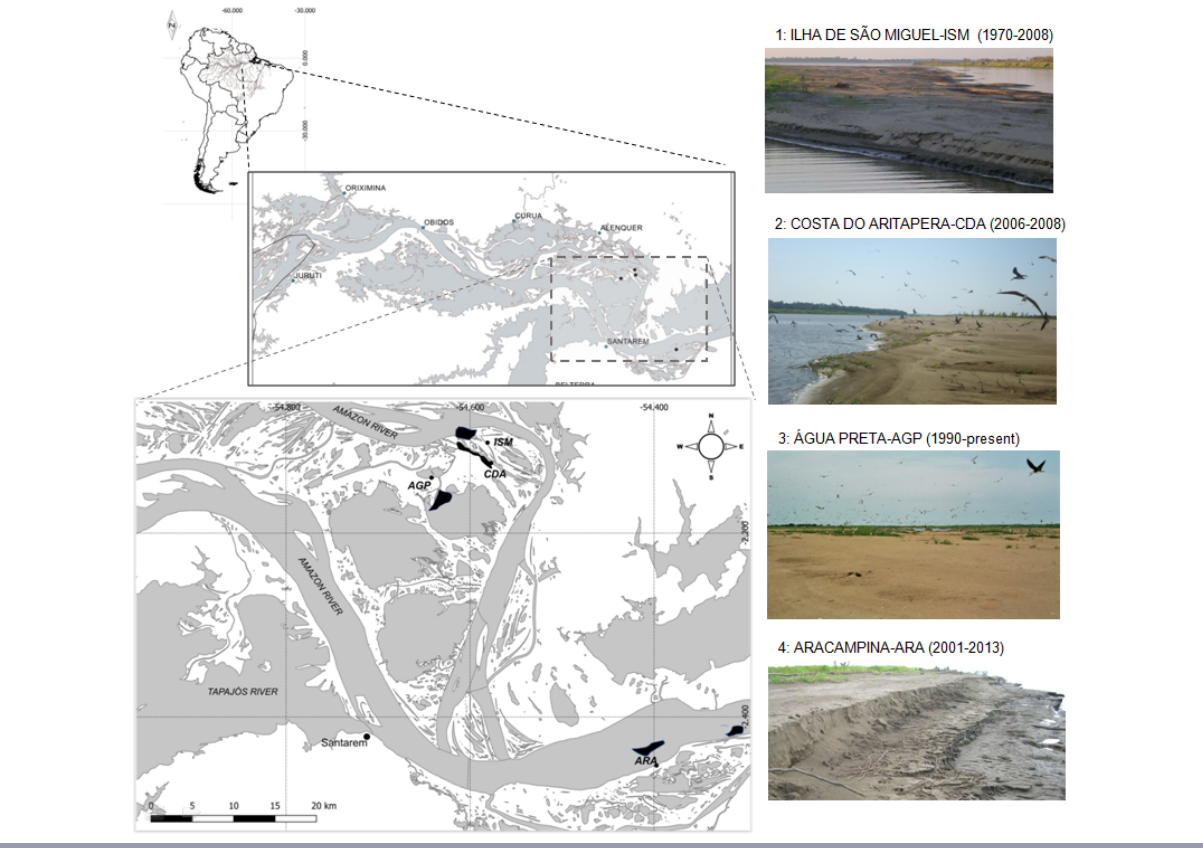
Fig. 2 . Map of the studied area showing the communities with their respective protected tabuleiros: Ilha de São Miguel (ISM), Costa do Aritapera (CDA), Água Preta (AGP), and Aracampina